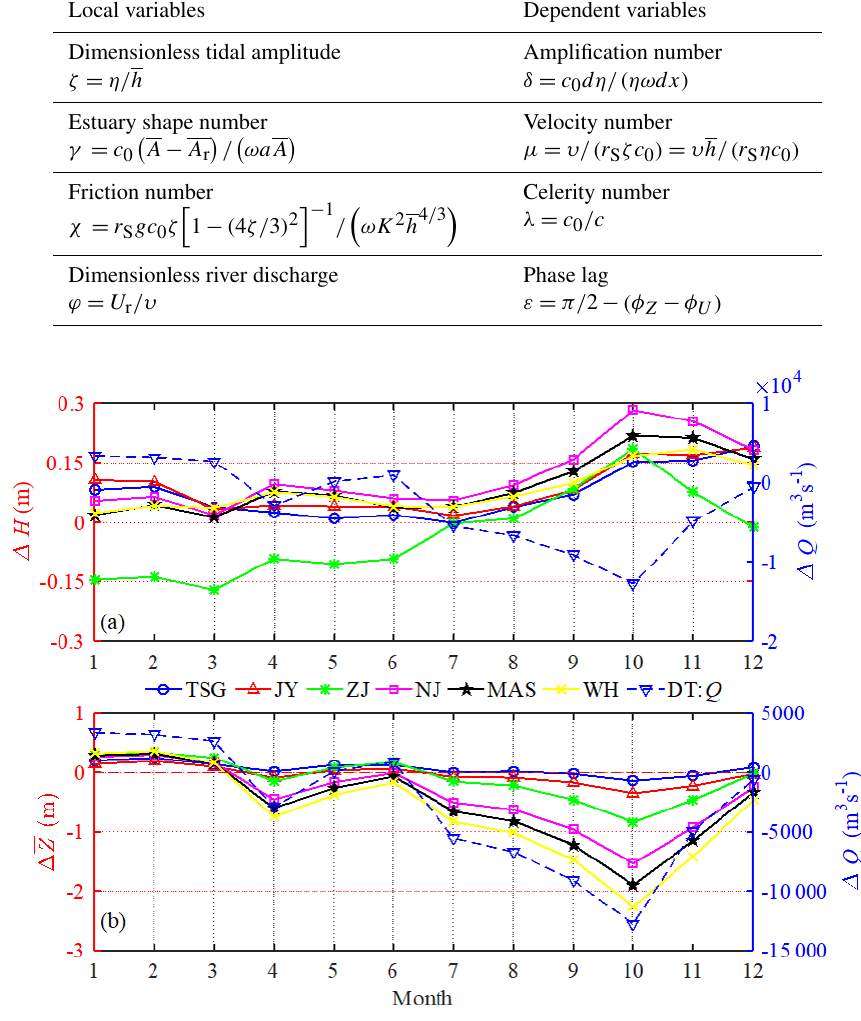
Figure 2. Changes in monthly averaged (a) tidal range (cid:49)H and (b) residual water level (cid:49)Z together with the freshwater discharge (cid:49)Q along the Yangtze River